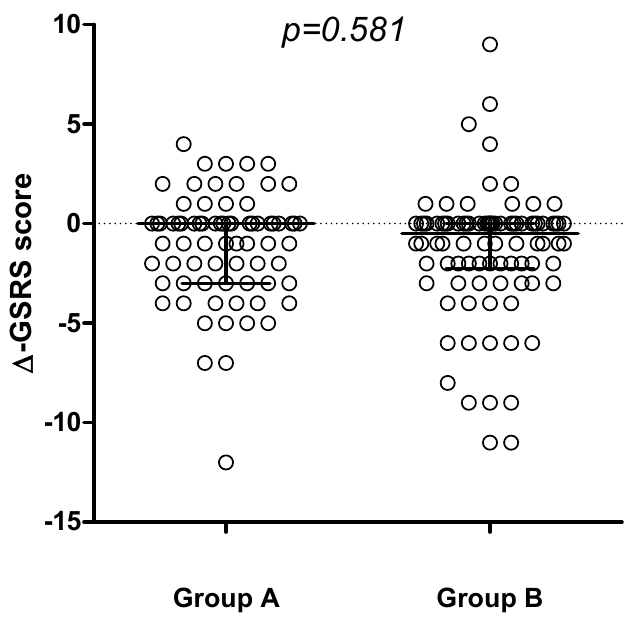
Figure 3. Change in GSRS score ( ∆ -GSRS score, median and IQR) between t6 and t0 in the 2